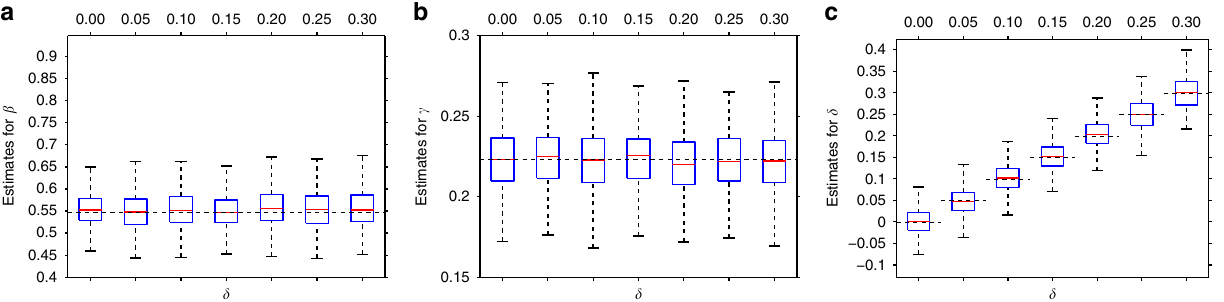
Fig. 1 Parameter estimation as a function of the G – E correlation. The correlation between the environmental variable ( E ) and the GRS ( G ), ranging from 0 to 0.3. Panels ( a – c ) show the boxplot of the estimates (from 500 simulated data sets) for parameters β 0 , γ 0 and δ 0 , respectively. Other parameters were fi xed as n = 10,000, α 0 ¼ 0 : 1, β 0 2 ¼ 0 : 3, γ 0 2 ¼ 0 : 05, E (cid:2) Nð 0 ; 1 Þ and ϵ (cid:2) Nð 0 ; σ 2 Þ . Boxes mark the fi rst ( q lower/upper whiskers are at q 1 − 1.5 ⋅ ( q 3 − q 1 ), q 3 + 1.5 ⋅ ( q 3 − q 1 ), respectively. Horizontal dashed lines indicate the true parameter values.